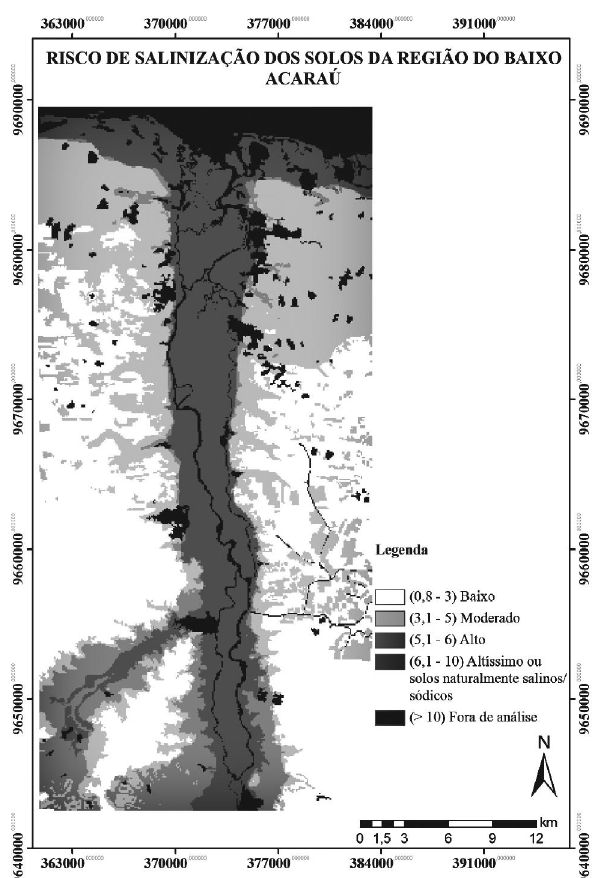
Figura 3. Mapa do risco de salinização das terras da região do Baixo Acaraú